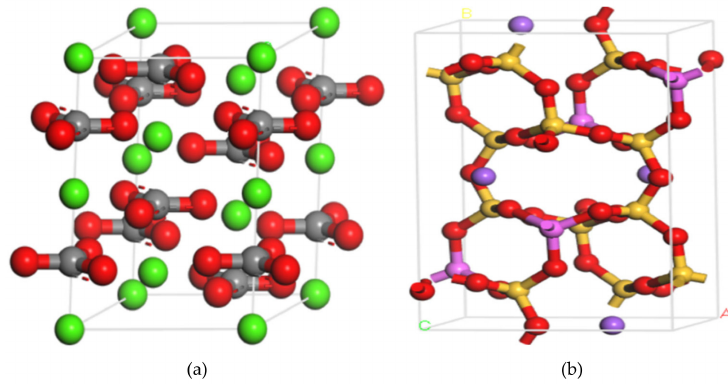
Figure 10. Aggregate cells of calcite and albite minerals (carbon: grey, calcium: green, oxygen: red, silica: orange, sodium: purple, aluminum: pink). ( a ) Calcite cell, ( b ) Albite cell.